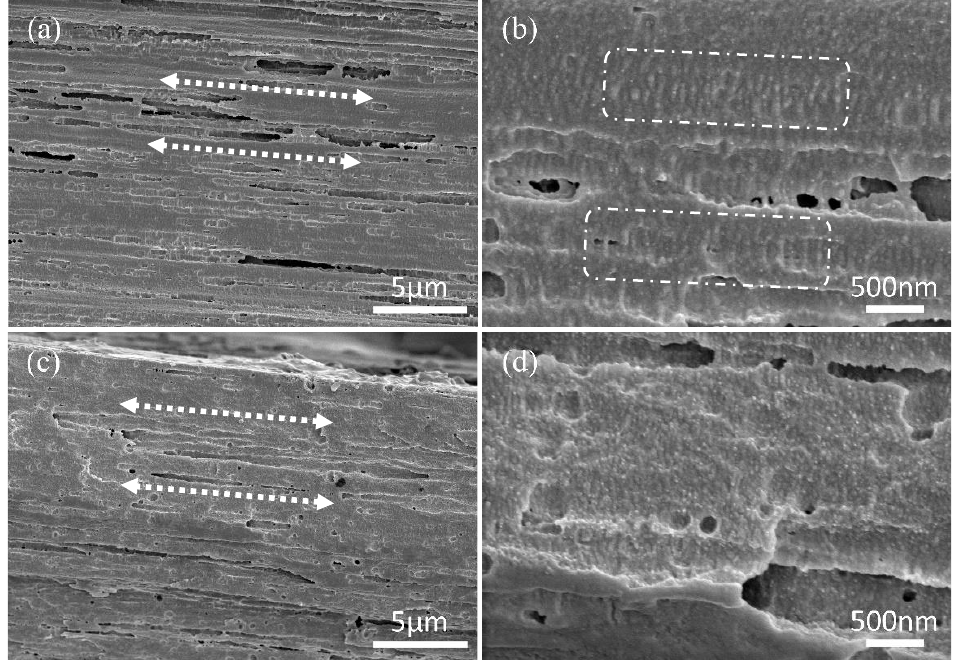
Figure 9. SEM images of the fractured surface of unannealed ( a , b ) and annealed ( c , d ) samples torn apart along the drawing direction in low-temperature medium.